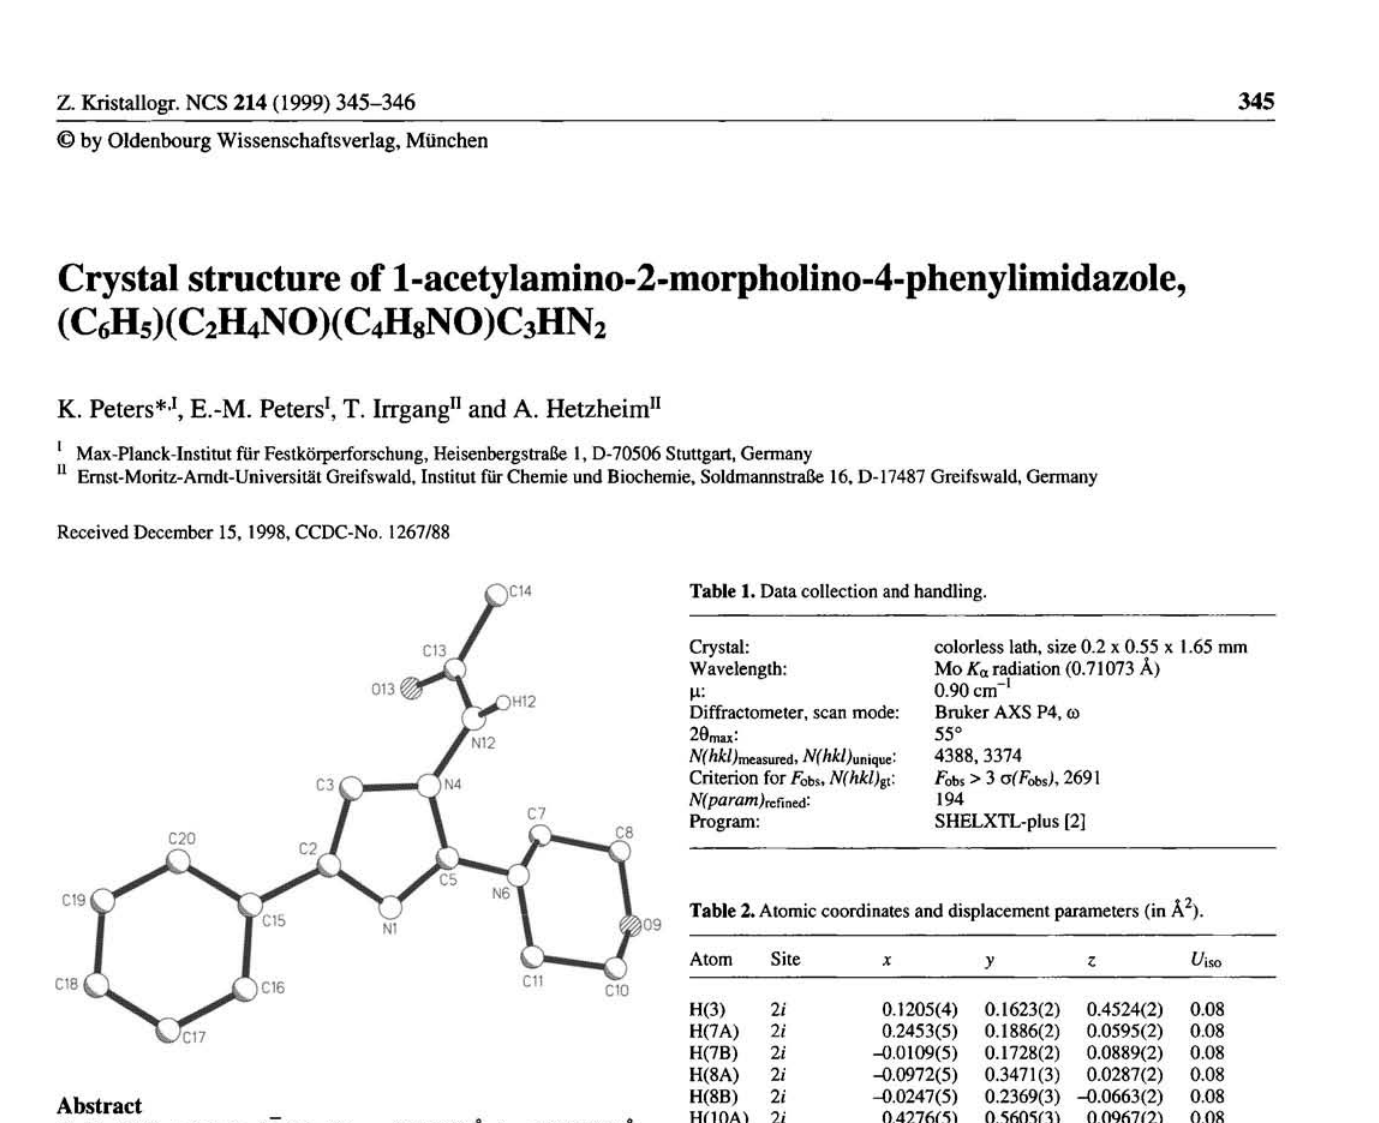
Table 2. Atomic coordinates and displacement parameters (in Â 2 ).